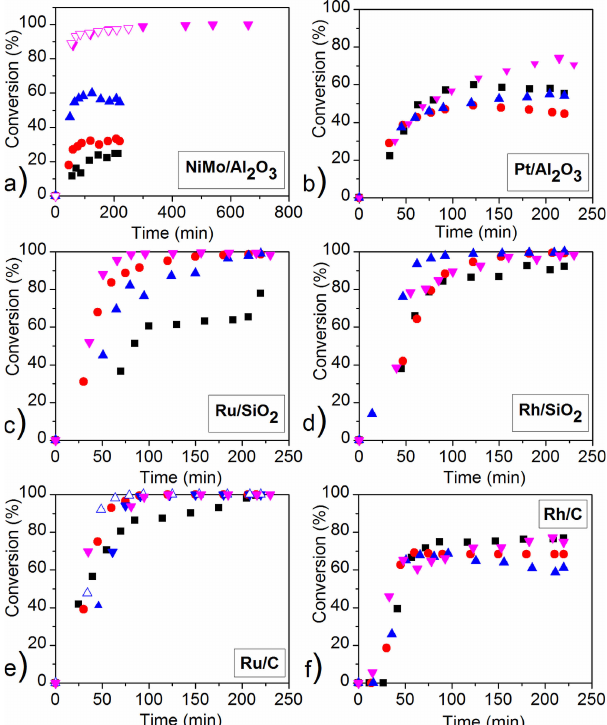
Figure 4. Conversion of mucic acid over ( a ) NiMo/ γ -Al 2 O 3 , ( b ) Pt/ Al 2 O 3 , ( c ) Ru/SiO 2 , ( d ) Rh/SiO 2 , ( e ) Ru/C, and ( f ) Rh/C at the (cid:4) T = 125 ◦ C, • T = 135 ◦ C, (cid:78) T = 150 ◦ C, and (cid:72) T = 175 ◦ C. Empty symbols represent results for repeated